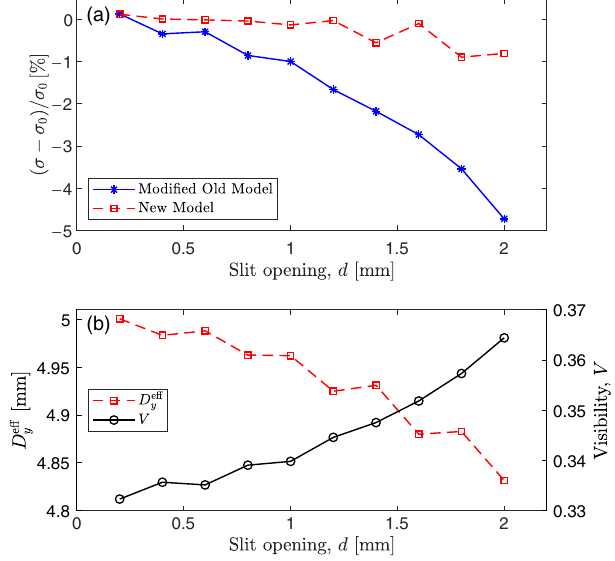
FIG. 6. Simulation results for a fixed size beam using a double slit with a fixed slit separation but a varying slit opening. (a) The relative difference between the fit beam size and the actual beam size. The blue solid line is the result using the old modified model; the red dashed line is the result based on the new model. (b) The effective slit separation D eff and visibility V extracted y from the fit parameters in the new model. The beam energy is ¼ 32 . 1 μ m, D ¼ 5 mm, L ¼ 2 m, L ¼ 2 m, 1000 MeV, σ 1 2 y y and a λ ¼ 340 nm wavelength filter is used in the